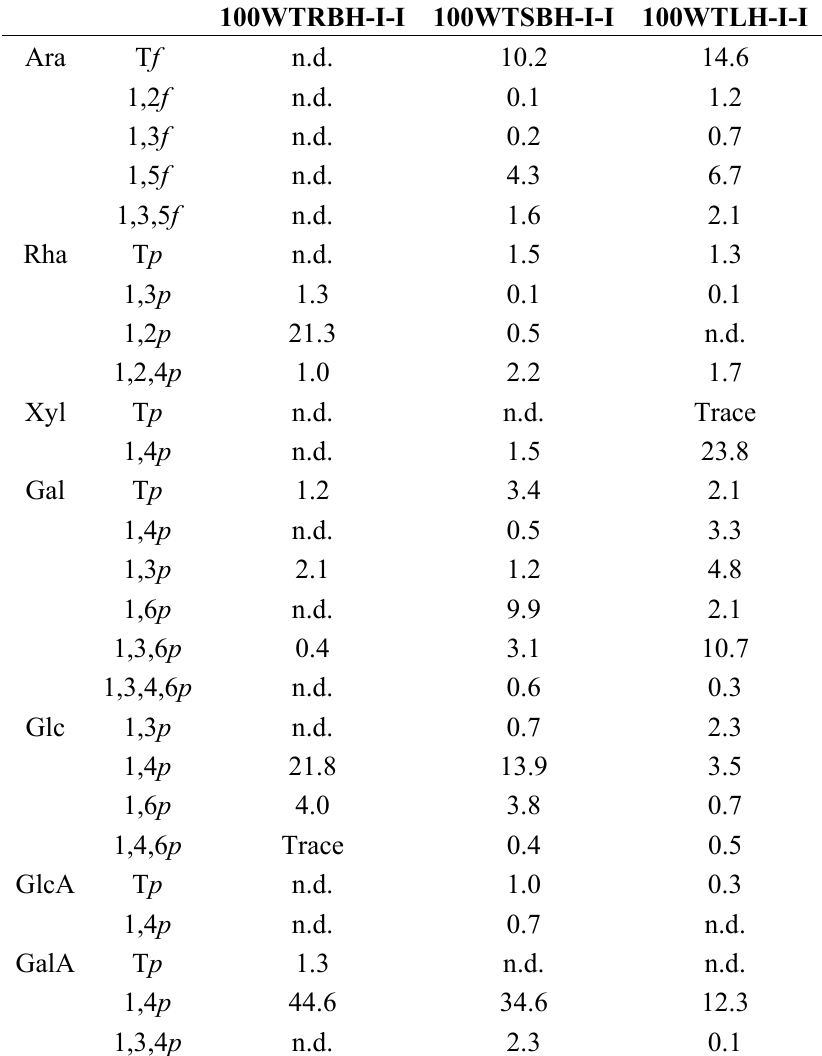
Table 3. The linkages (mol%) of the monosaccharides present in the most active purified fractions from root bark, stem bark and leaves of T. macroptera determined by GC–MS after